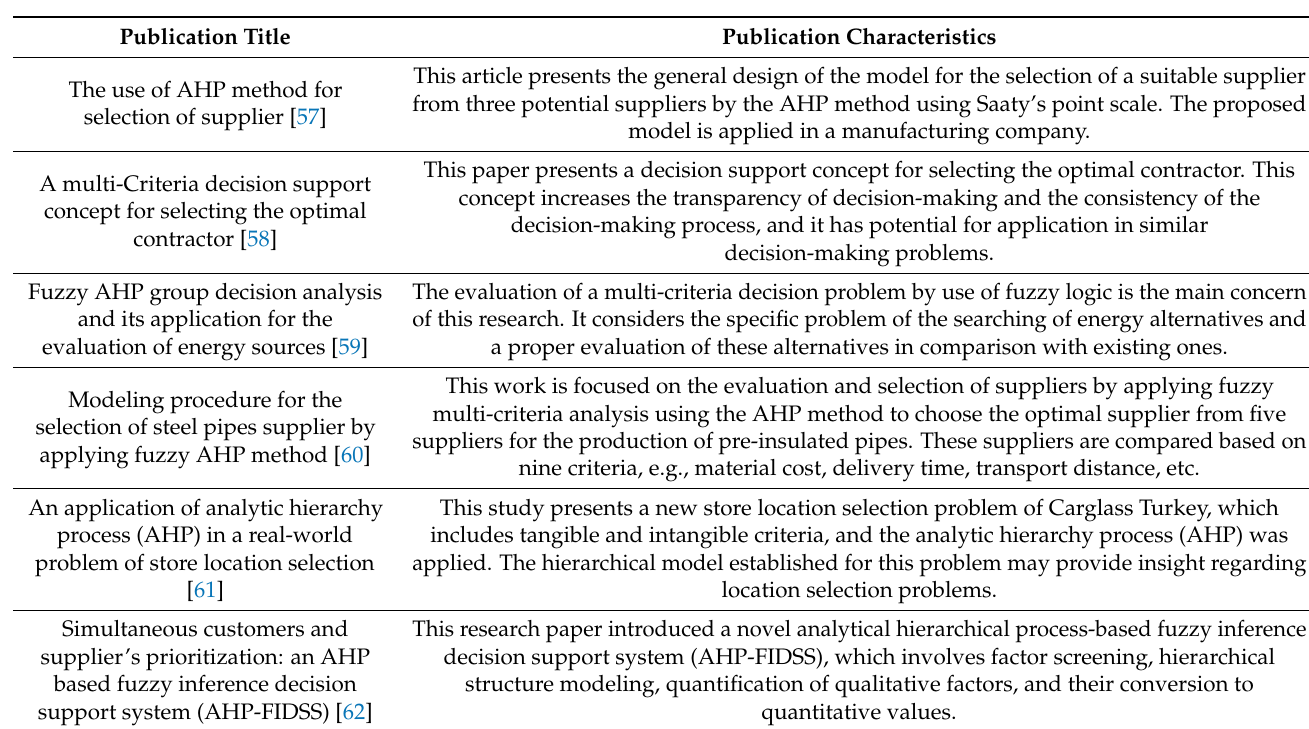
Table 1. Comparison of existing studies based on usage of AHP